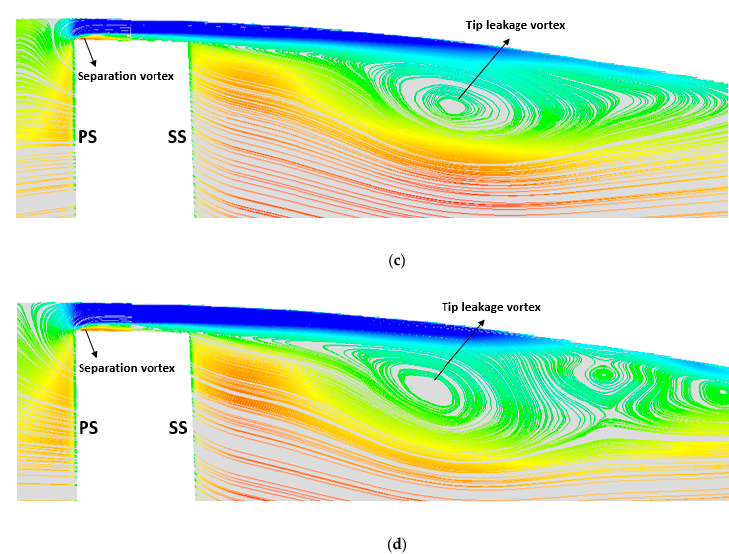
Figure 18. Distribution of non-dimensional mean axial velocities and streamlines at λ = 0.4 for varying tip clearance at φ = 0.354 (( a ) h = 0.1% span; ( b ) h = 0.3% span; ( c ) h =0.6% span; and ( d ) h =0.8% span).